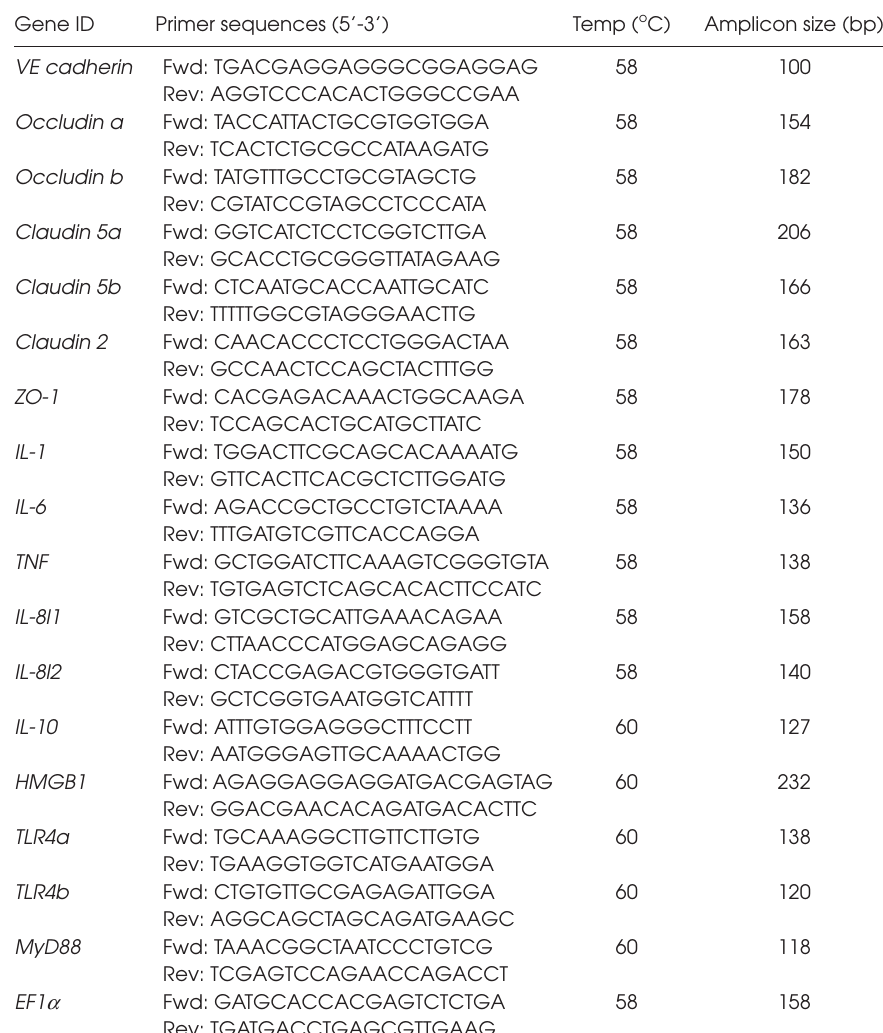
Table 1. Primer pairs used in this study Gene ID Primer sequences